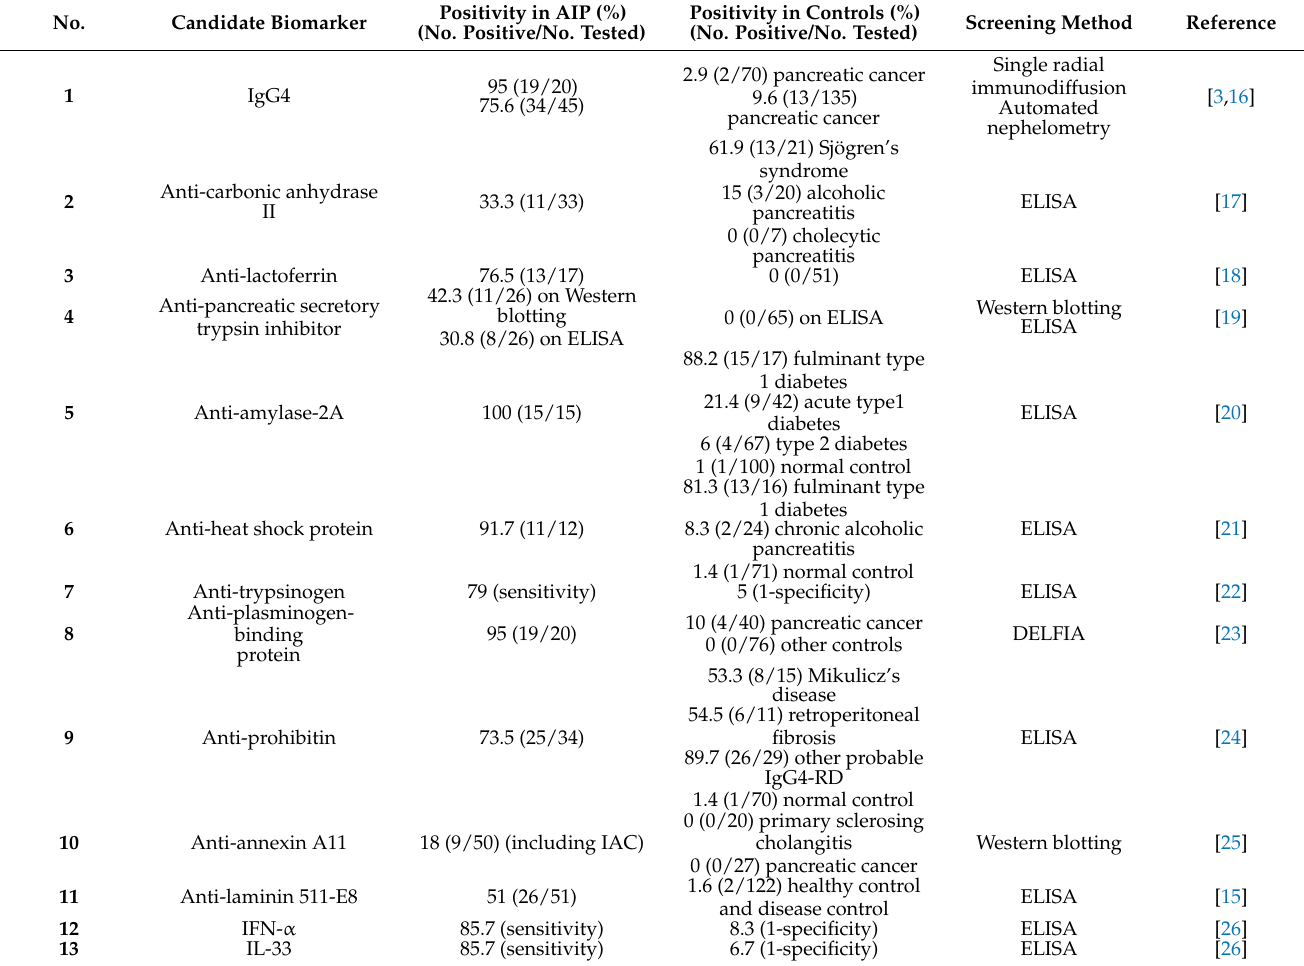
Table 1. Candidate biomarker for the diagnosis of autoimmune